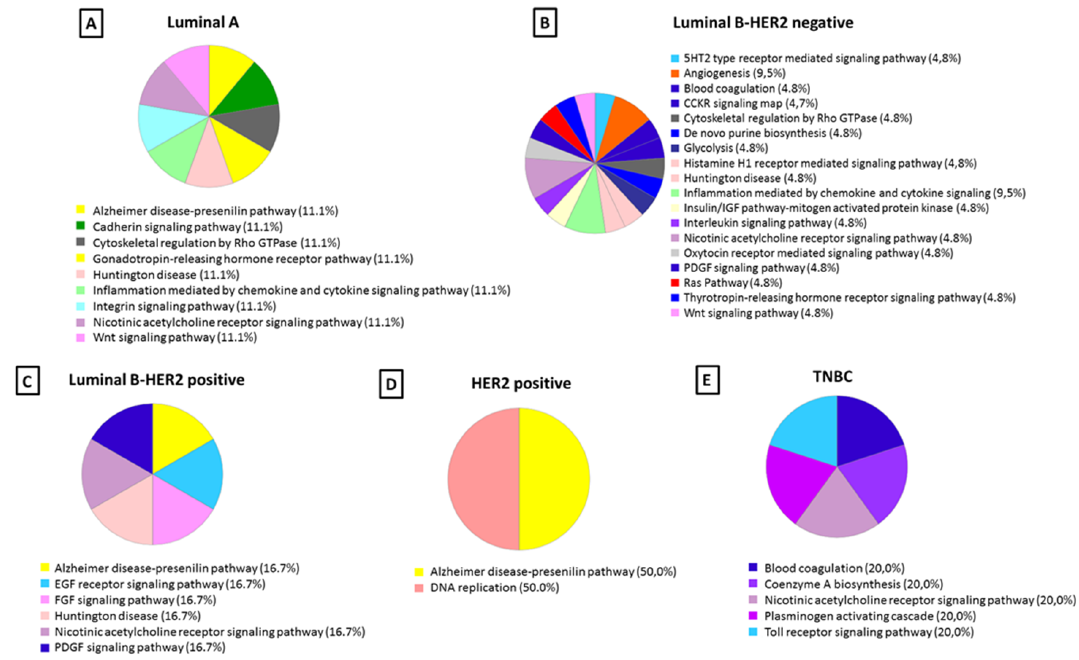
Figure 6. Classification according to the biological pathway of the proteins identified in the protein corona from each breast cancer subtype: ( A ) luminal A, ( B ) luminal B-HER2 negative, ( C ) luminal B-HER2 positive, ( D ) HER2 positive (n = 6), and ( E ) triple negative. The percentage in each category is the ratio between the number of proteins in each category, indicated in parentheses, and total proteins identified in that fraction.